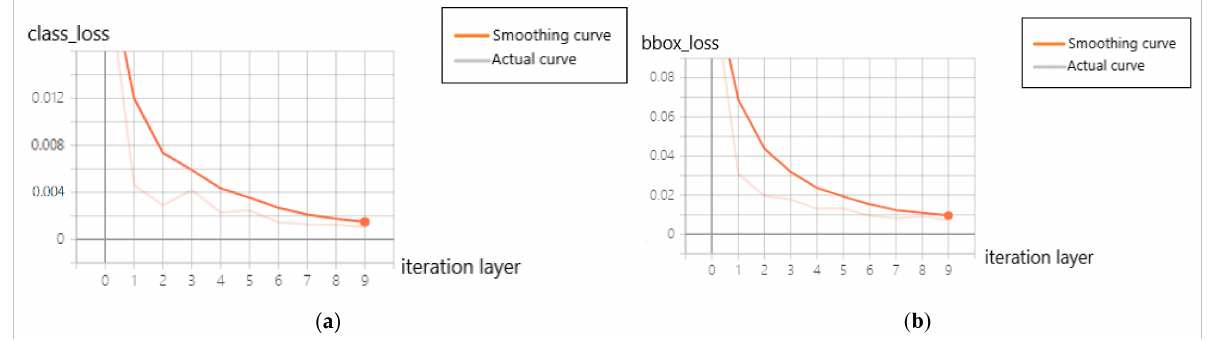
(1) The total number of iterations of the model is 10: